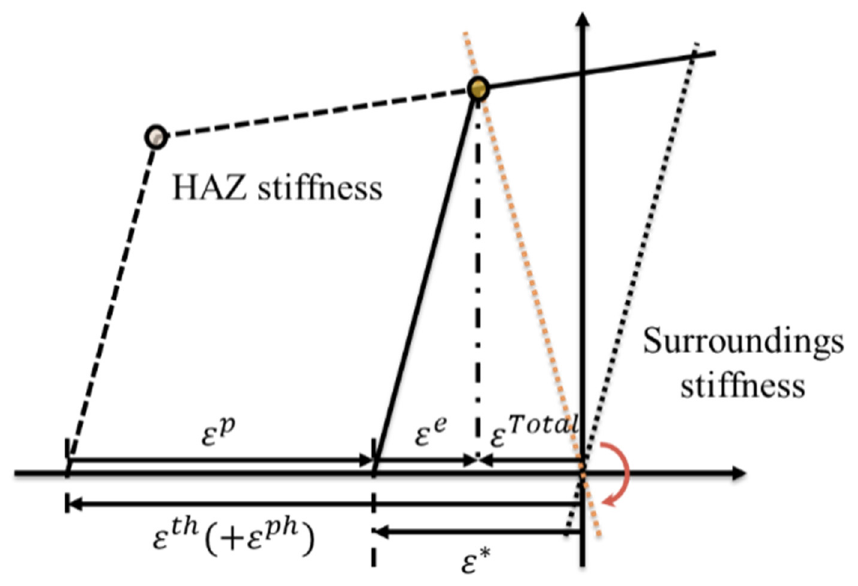
Figure 1. Stress–strain curve of heat affected zone (HAZ)